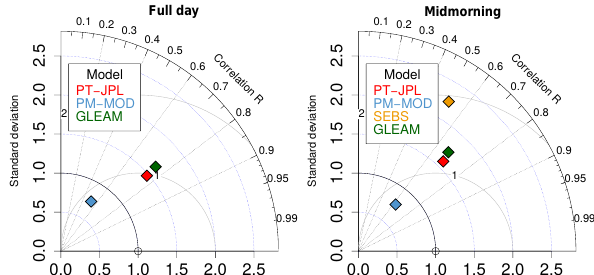
Figure 8. Taylor diagram plots of sinusoidal gridded model data against tower EC reference. Left panel: full-day 3-hourly data com- pared to 85 stations. Right panel: midmorning data (from 09:00 and 13:00LT) compared to 82 stations. Shown are the normalized stan- dard deviation, the normalized RMSD and the correlation coeffi- cient ( R